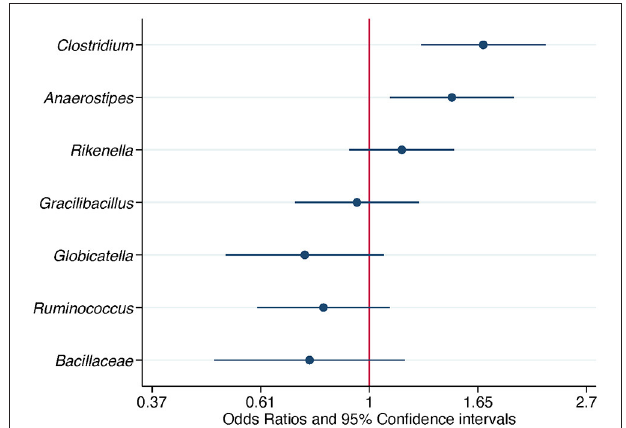
FIGURE 4 | Association of differentially abundant bacterial genera with the isolation of Campylobacter . Odds ratios and 95% confidence intervals were obtained from a conditional logistic regression model and adjusted for flock age and sampling season. Differentially abundant bacterial genera were detected in composite litter samples. Log scale was used in the abscissa. TABLE 5 | Association of differentially abundant amplicon sequence variants with the isolation of Campylobacter . Genus